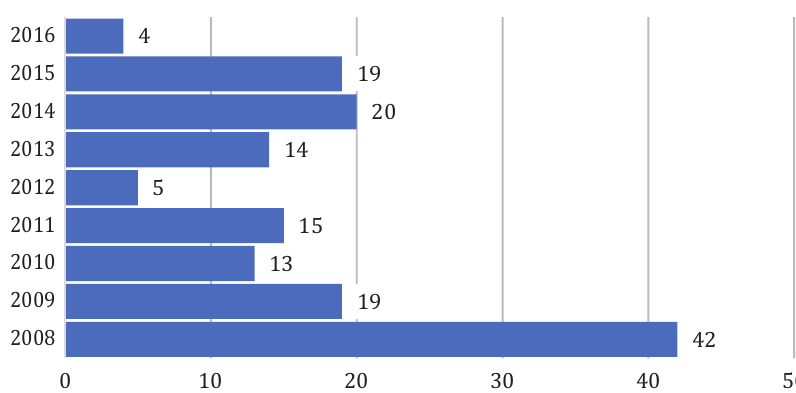
Figure 1. The number of the analyzed repaired road sections each